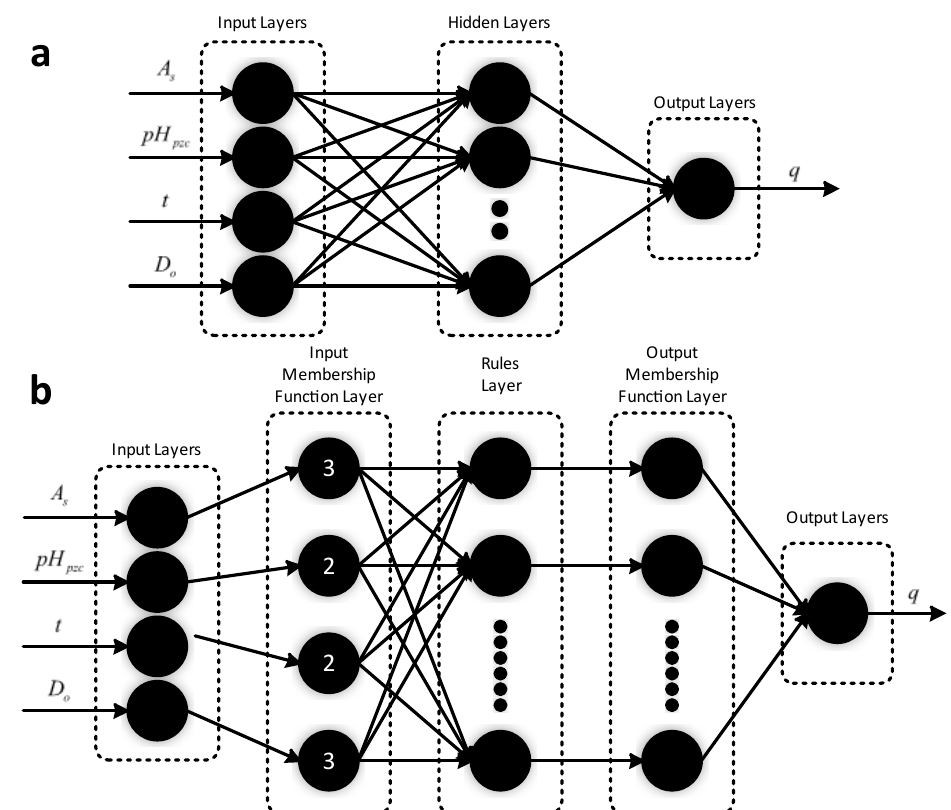
Figure 5. ( a ) Artificial neural network structure. ( b ) A simplified version of the ANFIS architecture. Reprinted with permission from Ref. [83]. Copyright 2020 Elsevier.